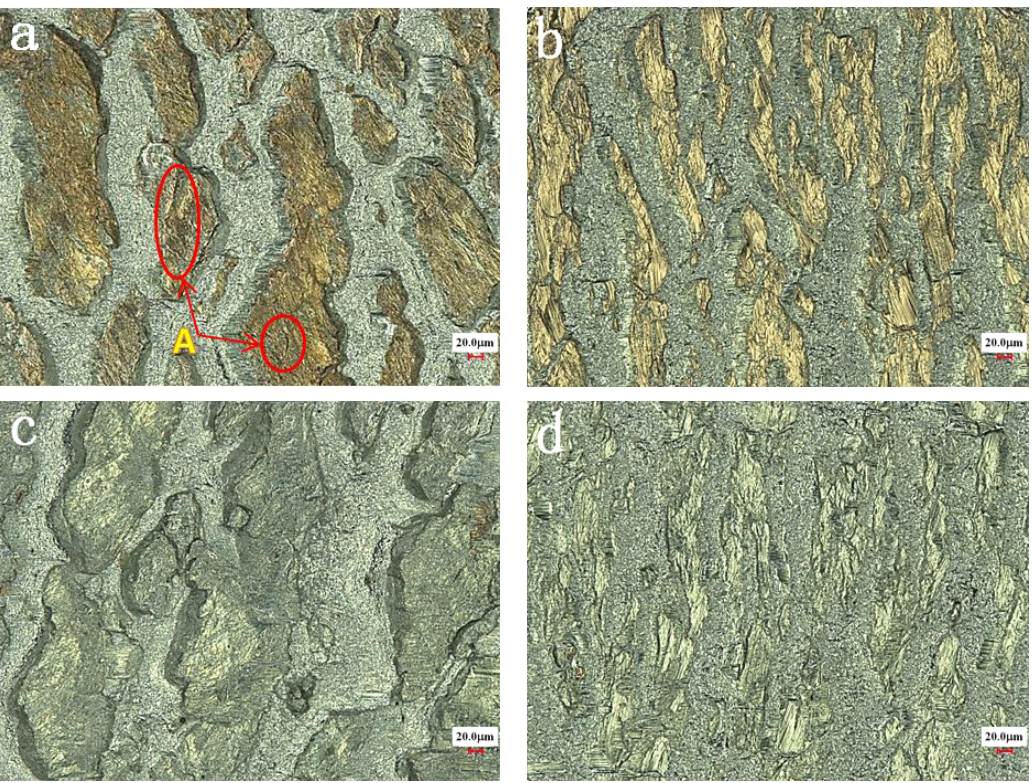
Figure 5. Optical microscopy using a super depth of field 3D microscope system showing the combined interface morphology: ( a ) unpulsed copper side; ( b ) pulse copper side; ( c ) unpulsed aluminum side; ( d ) pulse aluminum side.